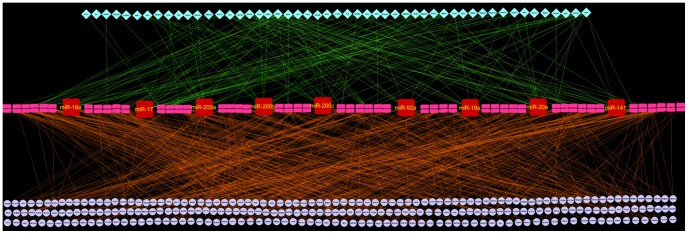
Tripartite regulatory network for Group 2 miRs.59 Group 2 miRs associated with the top 20 most significant GO Biological Processes were used to build this network. This network represents the molecular cross talk between TFs, miRs and mRNAs in PD. Square nodes in the middle layer represent miRs, diamond nodes in the upper layer representing validated TFs of respective miRs and circular nodes in the lower most layer represent mRNA targets of the miRs. Here regulation goes down from TFs to miRs and then miRs to mRNAs. TFs regulate the transcription of miRs whereas miRs regulate the translation process of target mRNAs. miRs with highest intermediate regulatory measure were denoted as IR hubs. The 9 IR hub miRs in the middle layer have been enlarged for proper visualization. These IR hubs represent the novel hub miRs which are not reported previously to be linked in PD. This network was constructed in Cytoscape interface [26].